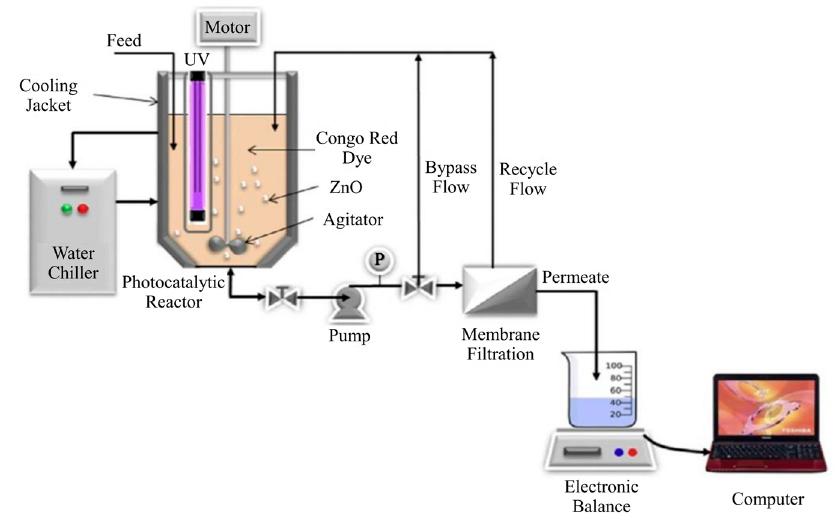
Figure 7. Schematic diagram of a typical split ‐ type PMR with suspended photocatalyst utilizing nanofiltration. Adapted with permission from [65], Copyright Elsevier,